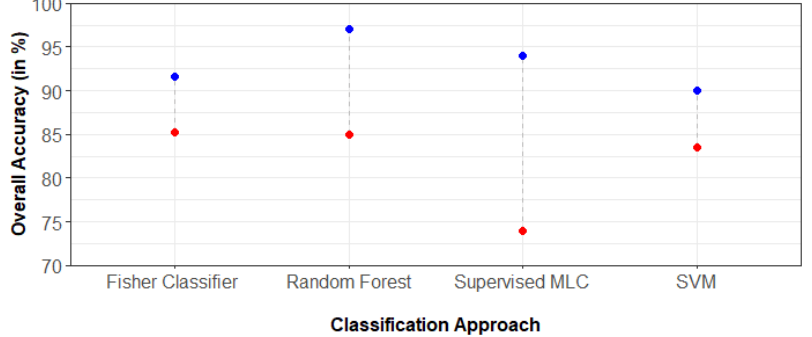
Figure 8. Range of overall classification accuracy in wetland-related studies based on classification approach.